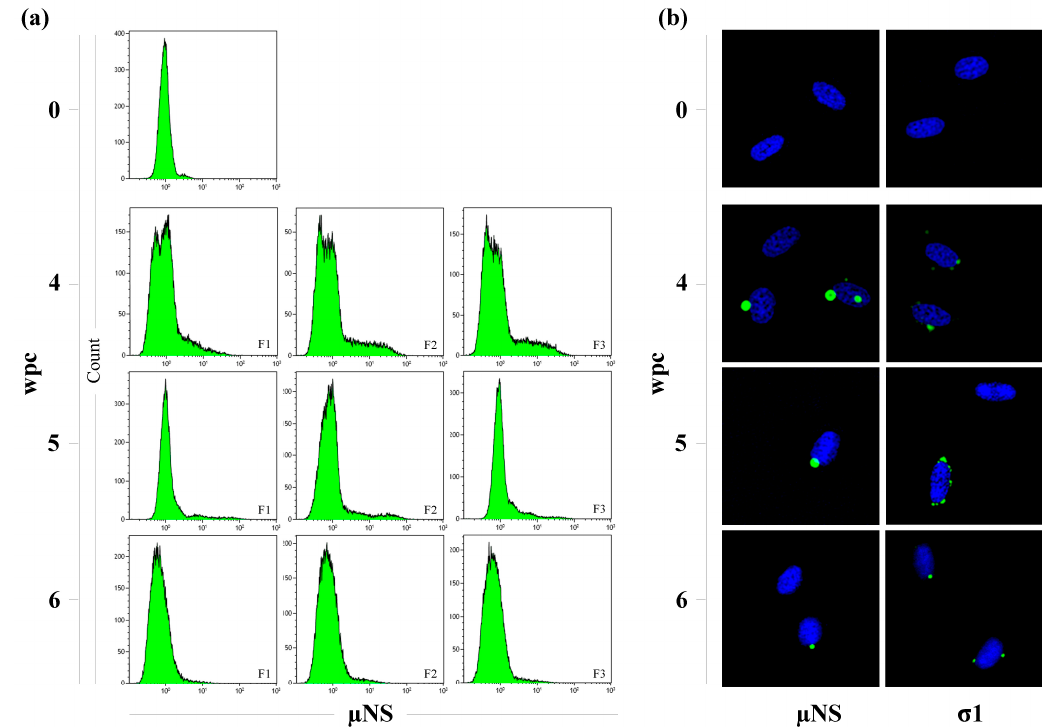
Figure 3. Presence of PRV µ NS and σ 1 in blood cells. ( a ) Intracellular staining of µ NS in blood cells analyzed by flow cytometry from three cohabitant fish sampled at 4, 5 and 6 wpc. The negative control staining is one fish sampled at 0 wpc. A total of 50,000 cells were counted per sample and 30,000 were gated for analysis; ( b ) Fluorescent labeling of µ NS (left) and σ 1 (right) displaying viral factory-like inclusions (green) in infected red blood cells sampled 0 (negative control), 4, 5 and 6 wpc. The nuclei were stained with Hoechst (blue). 348